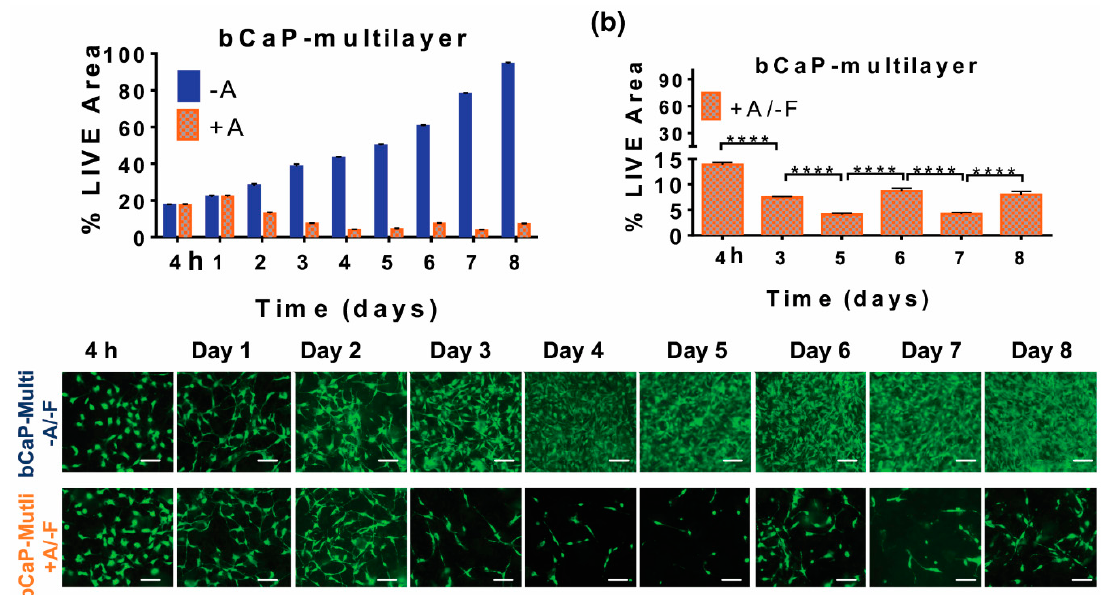
Figure 6. Kinetics of cell access when MC3T3-E1 osteoprogenitors were cultured on multilayers of bCaP without PEM: ( a ) percent LIVE ® stained area of MC3T3-E1s cultured on bCaP-1-bCaP2 (blue) as compared to cells cultured on AntiA-bCaP1-AntiA-bCaP2 (orange); ( b ) percent LIVE ® stained area of MC3T3-E1s cultured on AntiA-bCaP1-AntiA-bCaP2 (orange); ( c ) fluorescent images of cells on days 2, 3, 5, 6, 7 and 8. (**** p < 0.001) Scale bar = 100 µ m.